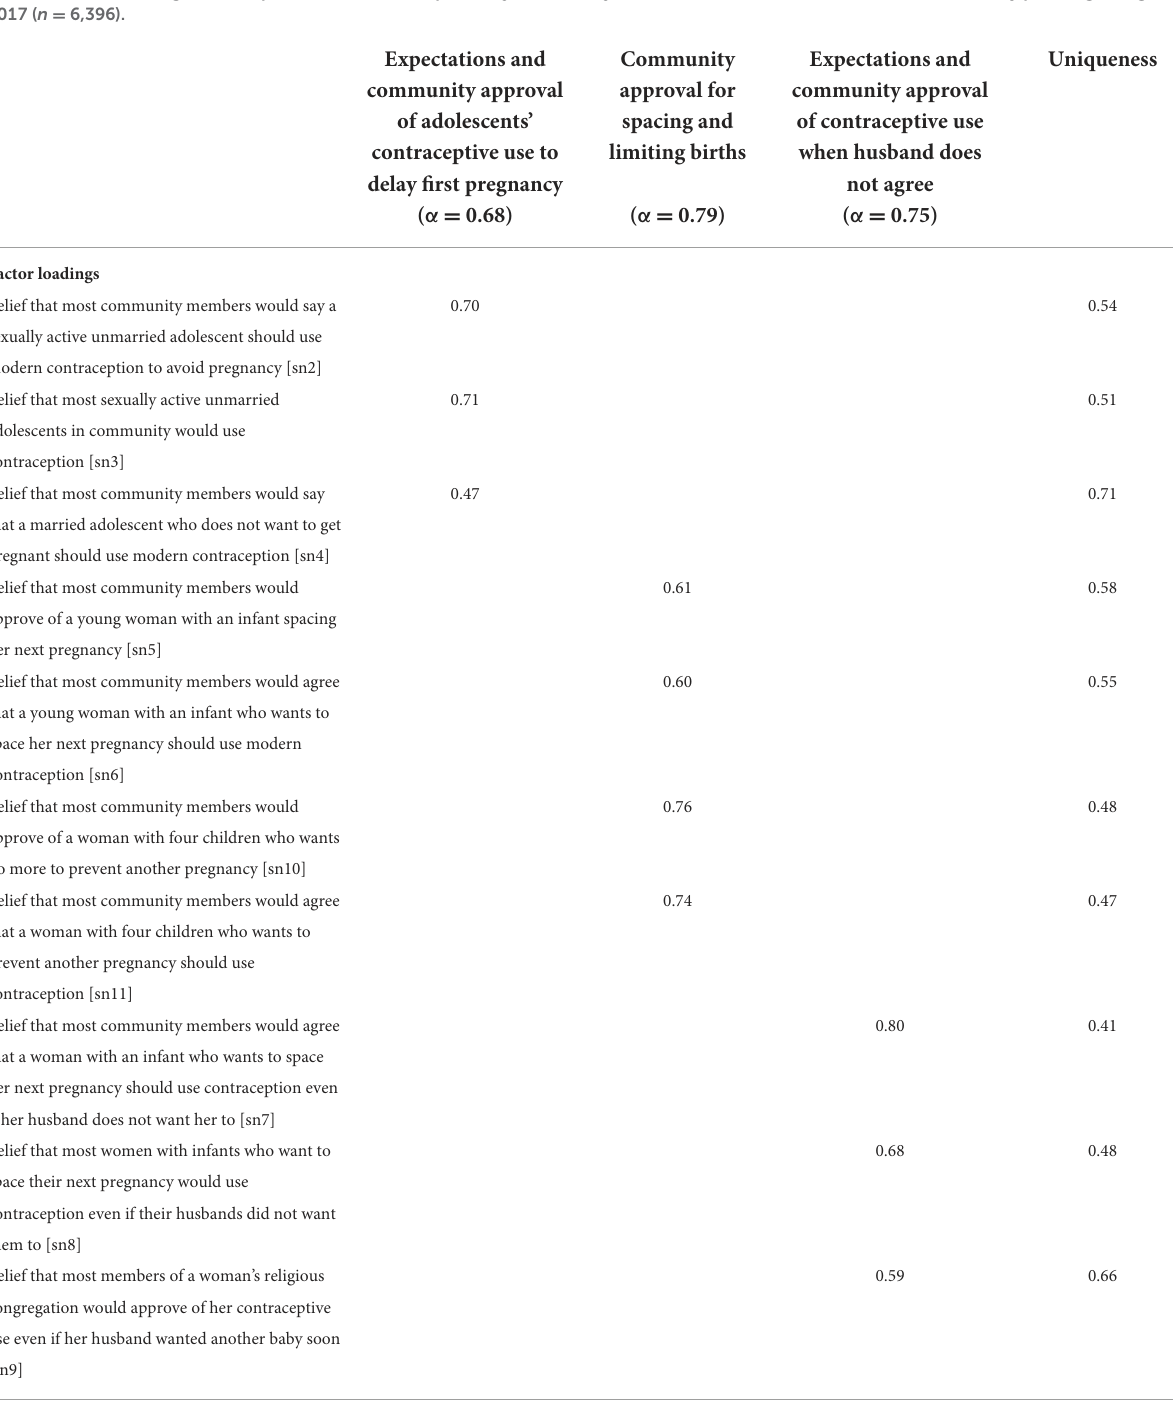
TABLE 2 Factor loadings and uniqueness’s based on exploratory factor analysis for items related to social norms around family planning in Nigeria, 2017 ( n = 6,396). Expectations and